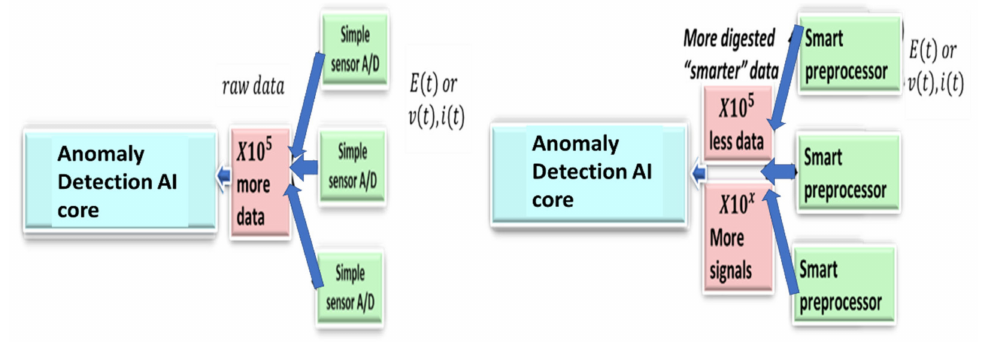
Figure 2. Classical electricity anomaly detection architecture vs. proposed architecture. Instead of raw data, a CPC preprocessor utilizes electricity knowledge to enhance core anomaly